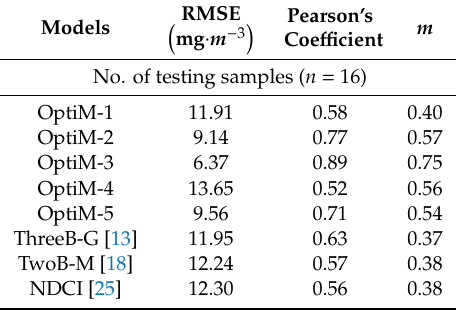
Table 4. Comparison of performance of Chl-a estimation models using the RMSE, Pearson’s correlation coe ffi cient, and slope